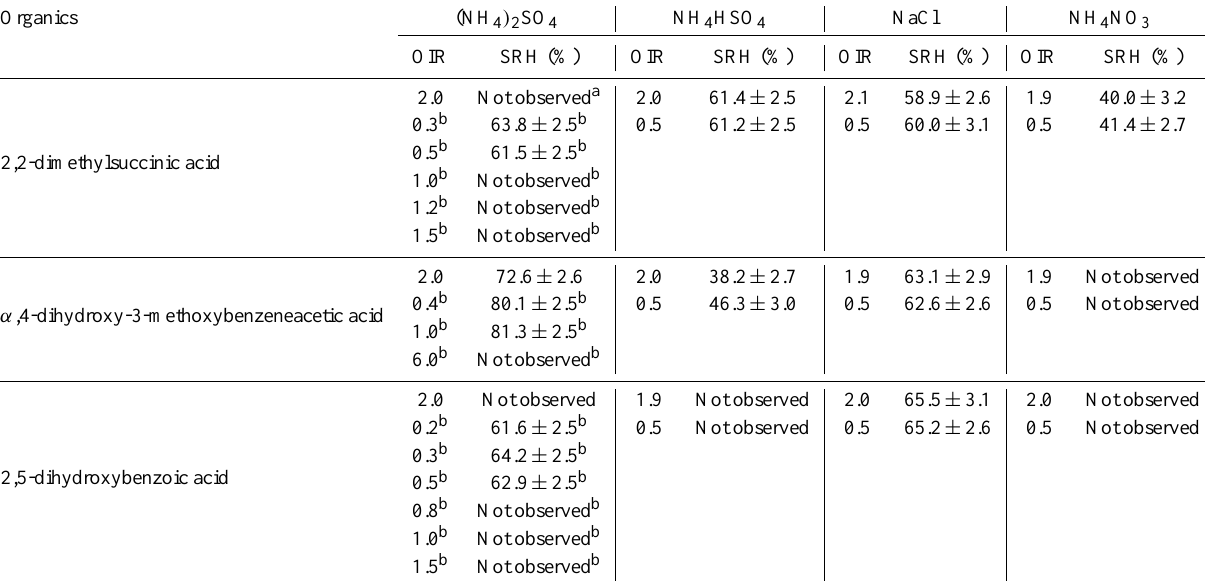
Table 4. Summary of SRH results as a function of the organic-to-inorganic (OIR) mass ratio for following organics: 2,2-dimethylsuccinic acid; α ,4-dihydroxy-3-methoxybenzeneacetic acid; and 2,5-dihydroxybenzonic acid. Included are results from both the current studies and results from Bertram et al. (2011). Uncertainties represent 2 σ of multiple SRH measurements and the uncertainty from the calibration.